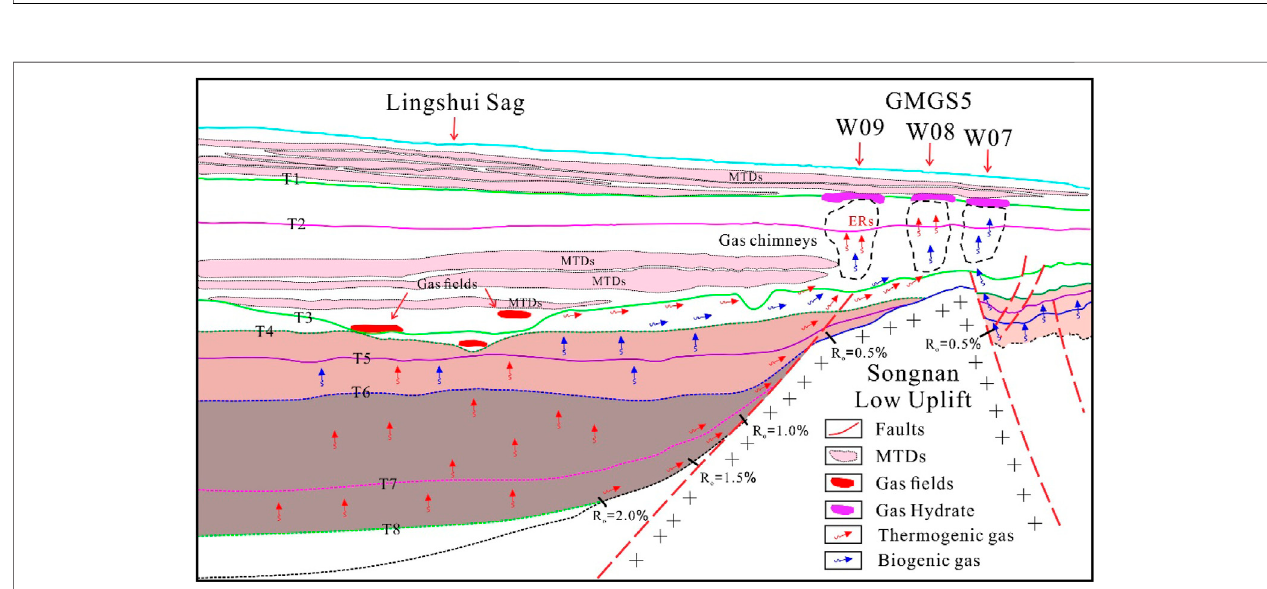
FIGURE 9 | Hydrocarbon-charging and gas hydrate accumulation model of the Songnan Low Uplift in the QDNB.